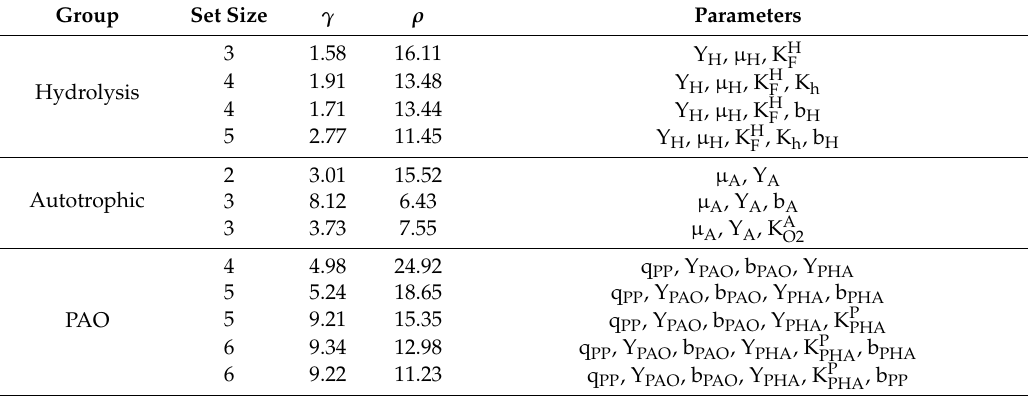
Table 1. Collinearity index ( γ ) and determinant measure ( ρ ) of selected parameters subsets. Based on their function, the parameters are categorized into different process groups, i.e., hydrolysis, autotroph, and PAO-related processes. The subset in bold is selected for parameter estimation based on values of γ and ρ